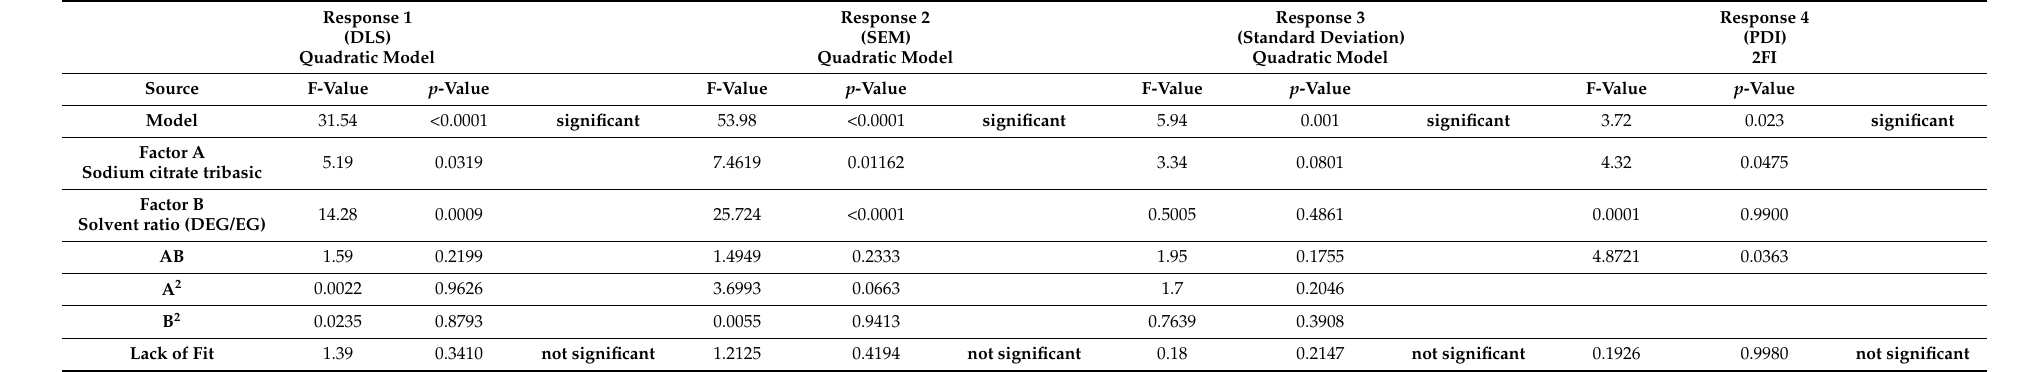
Table 2. ANOVA (summary for the four responses) for the Quadratic and 2FI